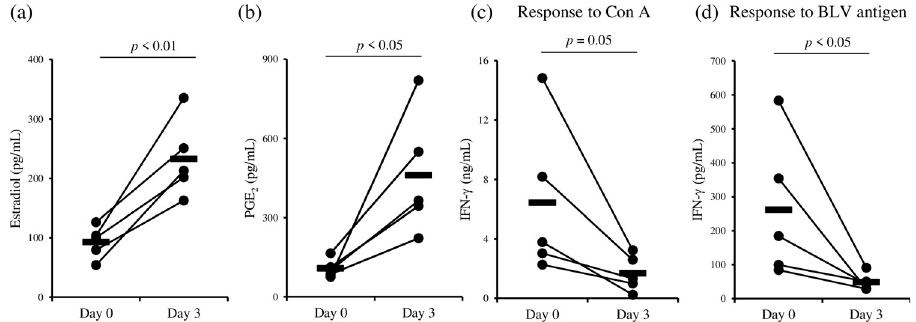
Fig 4. Functional analysis of estradiol using BLV-infected cattle ( n = 5, animals #6–#10). (a) Serum estradiol concentrations were measured by ELISA. (b) Serum PGE 2 concentrations were measured by ELISA. (c and d) Whole- blood cultures or PBMC cultures were performed to evaluate IFN- γ production in response to Con A or gp51 peptide mix, respectively. (a–d) Statistical significance was determined by Welch’s t test (a–d).